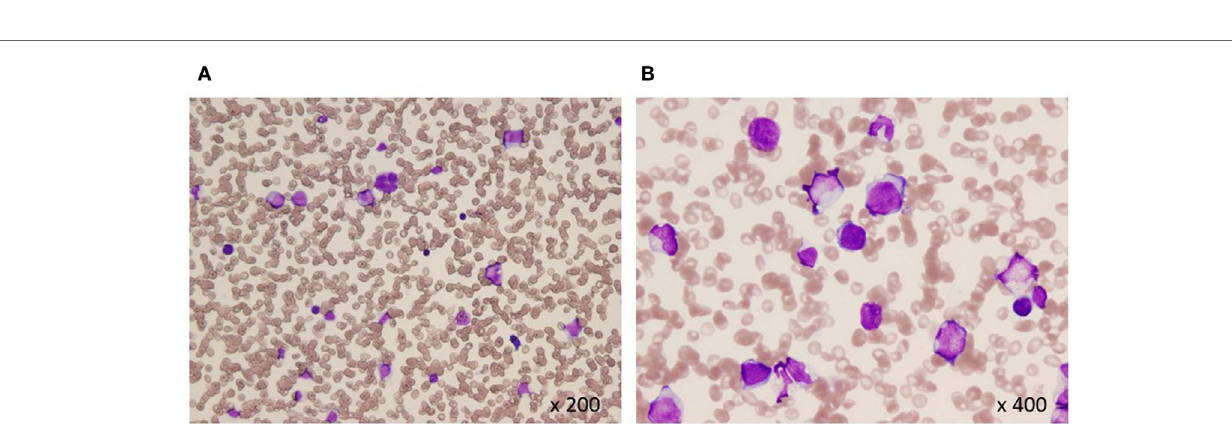
FIGURe 1 | Histopathology of a Sweet’s syndrome lesion. Closer views (a) of Sweet’s syndrome lesions located on the upper arms are shown. The biopsy specimen (B) shows a confluent neutrophilic infiltrate in the reticular dermis and edema in the papillary dermis (hematoxylin and eosin